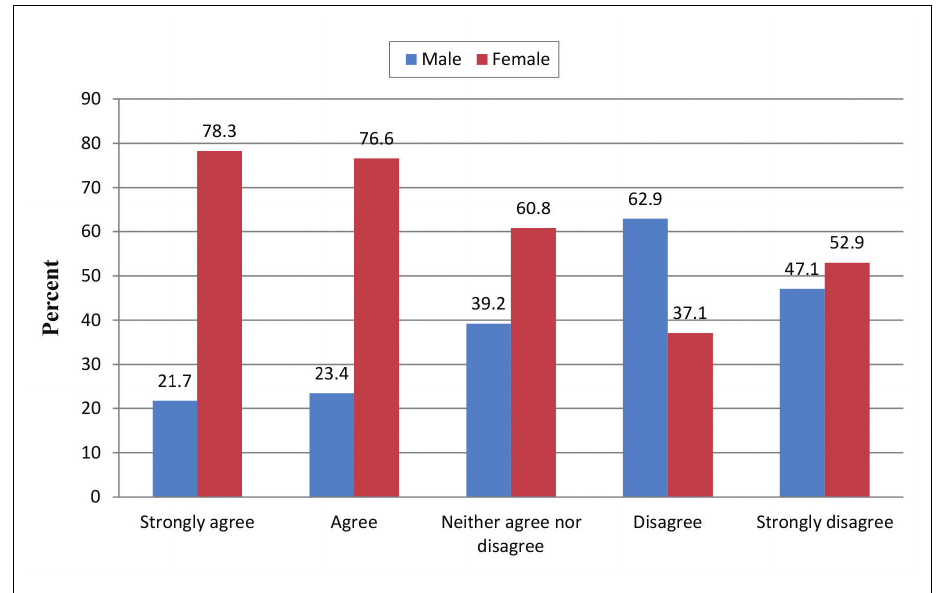
Figure 3. Participants’ level of anxiety in the foreign language class as compared to other classes with respect to